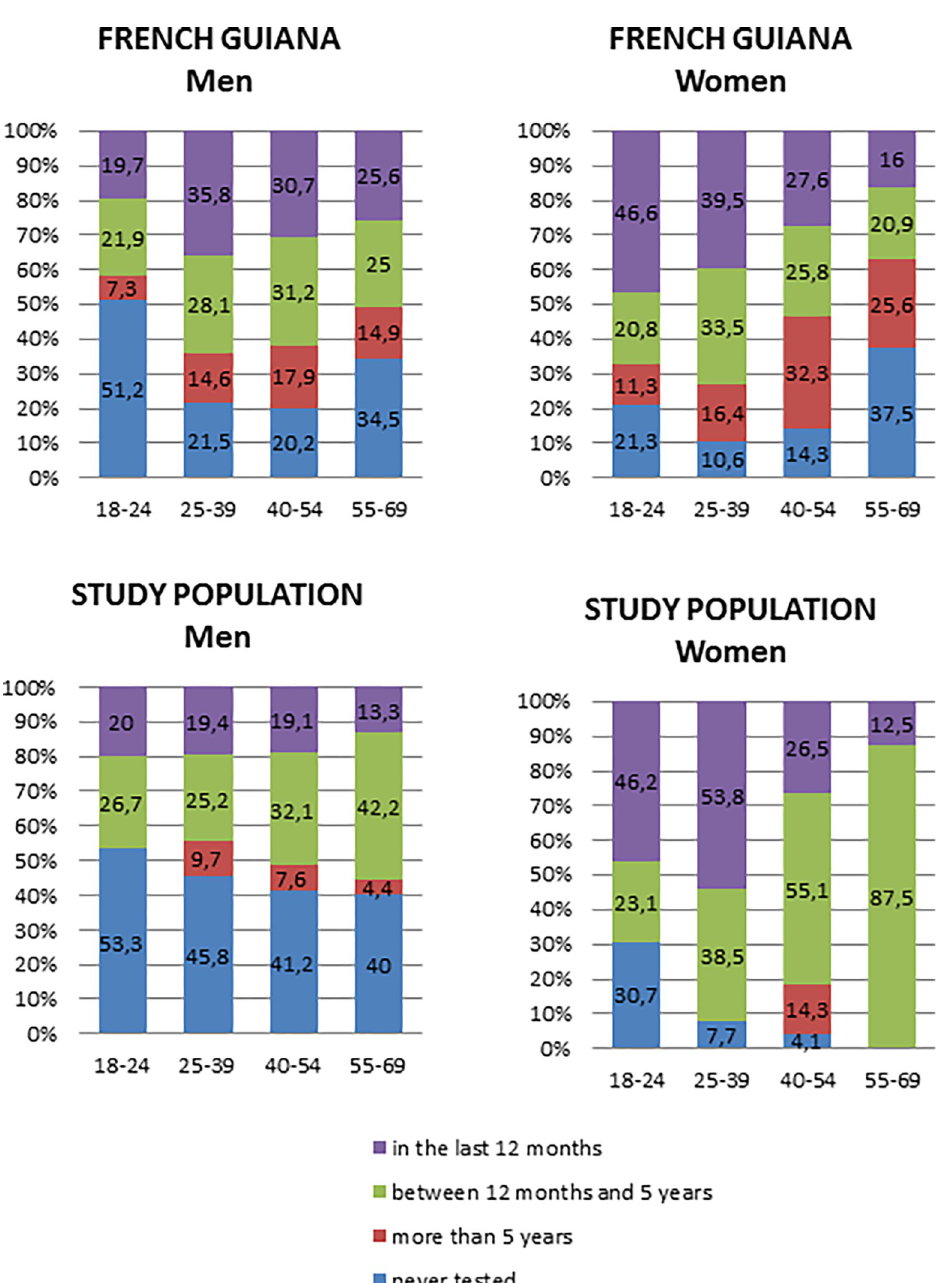
Fig 1. Previous HIV test among the study population and the French Guianese population by sex and age.